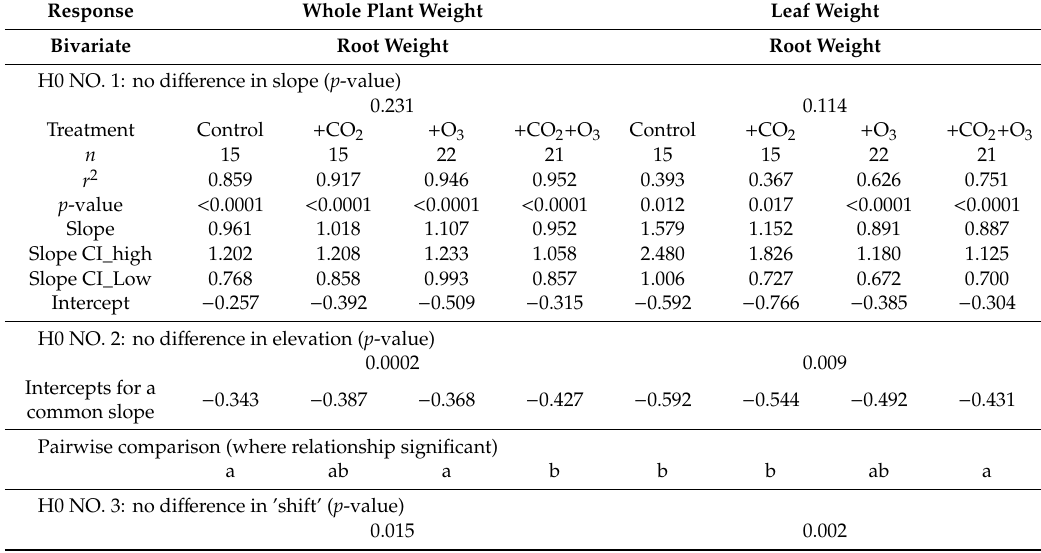
Table 4. Standardized major axis (SMA) regression slopes and their confidence intervals for log-log transformed relationships between whole plant weight and root weight (Figure 3A) and between root weight and leaf weight (Figure 3B) of F. crenata seedlings grown under ambient air (control), elevated CO 2 ( + CO 2 ), elevated O 3 ( + O 3 ), and the combination of elevated CO 2 and O 3 ( + CO 2 + O 3 ). Values of coe ffi cients of determination ( r 2 ) and significant values ( p ) of each bivariate relationship are shown. 95% confidence intervals (CI) of SMA slopes and y -axis intercepts are exhibited. In cases where SMA tests for common slopes revealed no significant di ff erences between treatments, common slopes are used. The di ff erences in elevations of the SMA regressions are tested among treatments using Sidak’s adjusted pair-wise test, depending on the significance of the null hypothesis that the slopes are equal. Where there is a significant di ff erence in elevation of the common-slope SMA regressions, values for the y -axis intercept (elevation) are provided. Di ff erent letters in pairwise comparison are significantly di ff erent, with a p < 0.05 under the slopes are equal. Where appropriate, significant shifts along a common slope are indicated. The format of table is referred that in Atkin et al. [59].